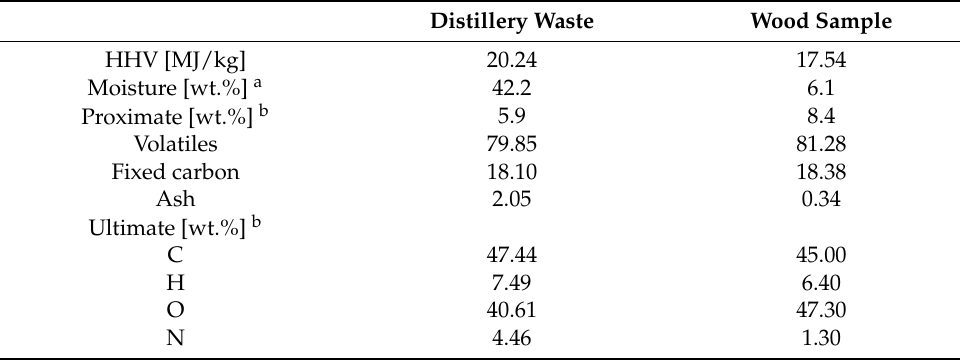
Table 1. Proximate and ultimate analysis of distillery waste. Distillery Waste Wood